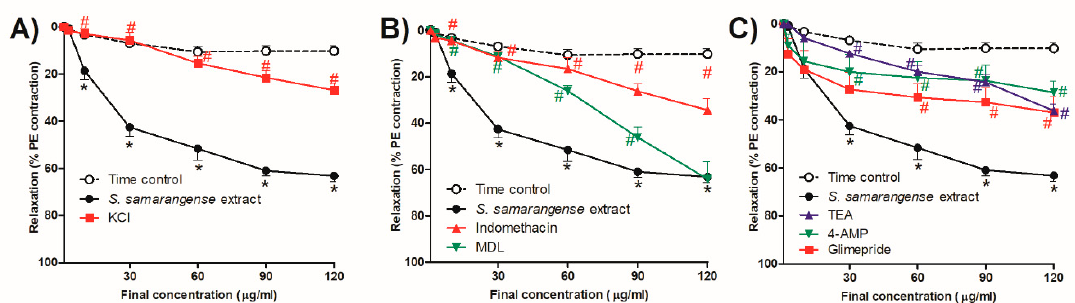
Figure 4. Effects of the cumulative addition of S. samarangense extract doses (1–120 g/mL) on isolated aortas from control animals that had been preconstricted by phenylephrine (PE, 10 M). The effect of preincubation (30 min) with ( A ) KCl (30 mM), as a membrane hyperpolarization inhibitor; ( B ) Indomethacin (INDO, 10 M), an inhibitor of cyclooxygenase; and cis-N-(2-Phenylcyclopentyl) azacyclotridec-1-en-2-amine, as an adenylate cyclase inhibitor. ( C ) Tetraethylammonium chloride (TEA, 10 mM), as a blocker of the standard voltage-dependent K + channels, HCl (MDL, 30 M), the standard Ca 2+ -gated K + channel blocker (4-AP, 1 mM), and glimepiride (10 µ M) as a Sarc K + ATP channel blocker on the vasodilation effect of S. samarangense extract on PE preconstricted aorta sections. The results are displayed as the mean ± standard error of six animals. By using a two-way ANOVA and the Bonferroni post hoc test, the results were statistically significant when compared to the time control values, * p < 0.05 and the effect of the S. samarangense extract on intact endothelium # p < 0.05, respectively.